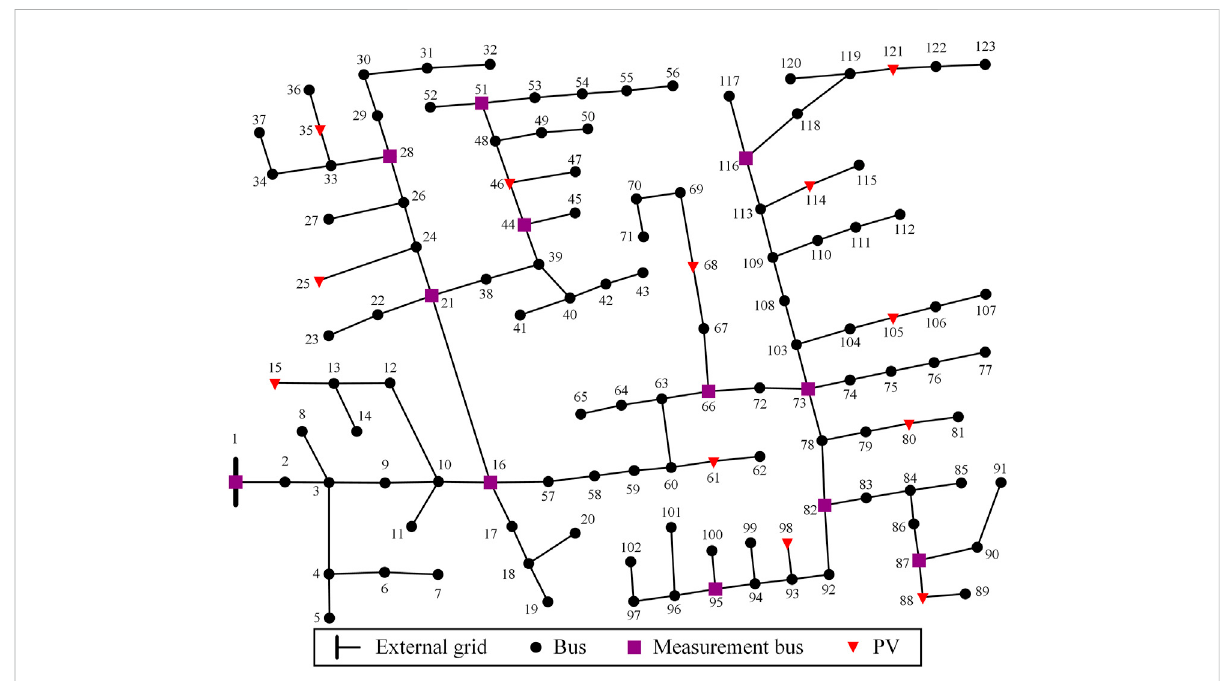
FIGURE 4 Topology of the extended IEEE-123 bus distribution system.